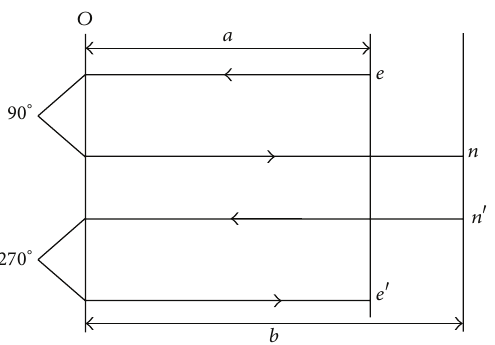
Figure 11: Schematic diagram of the main cam motion cycle.